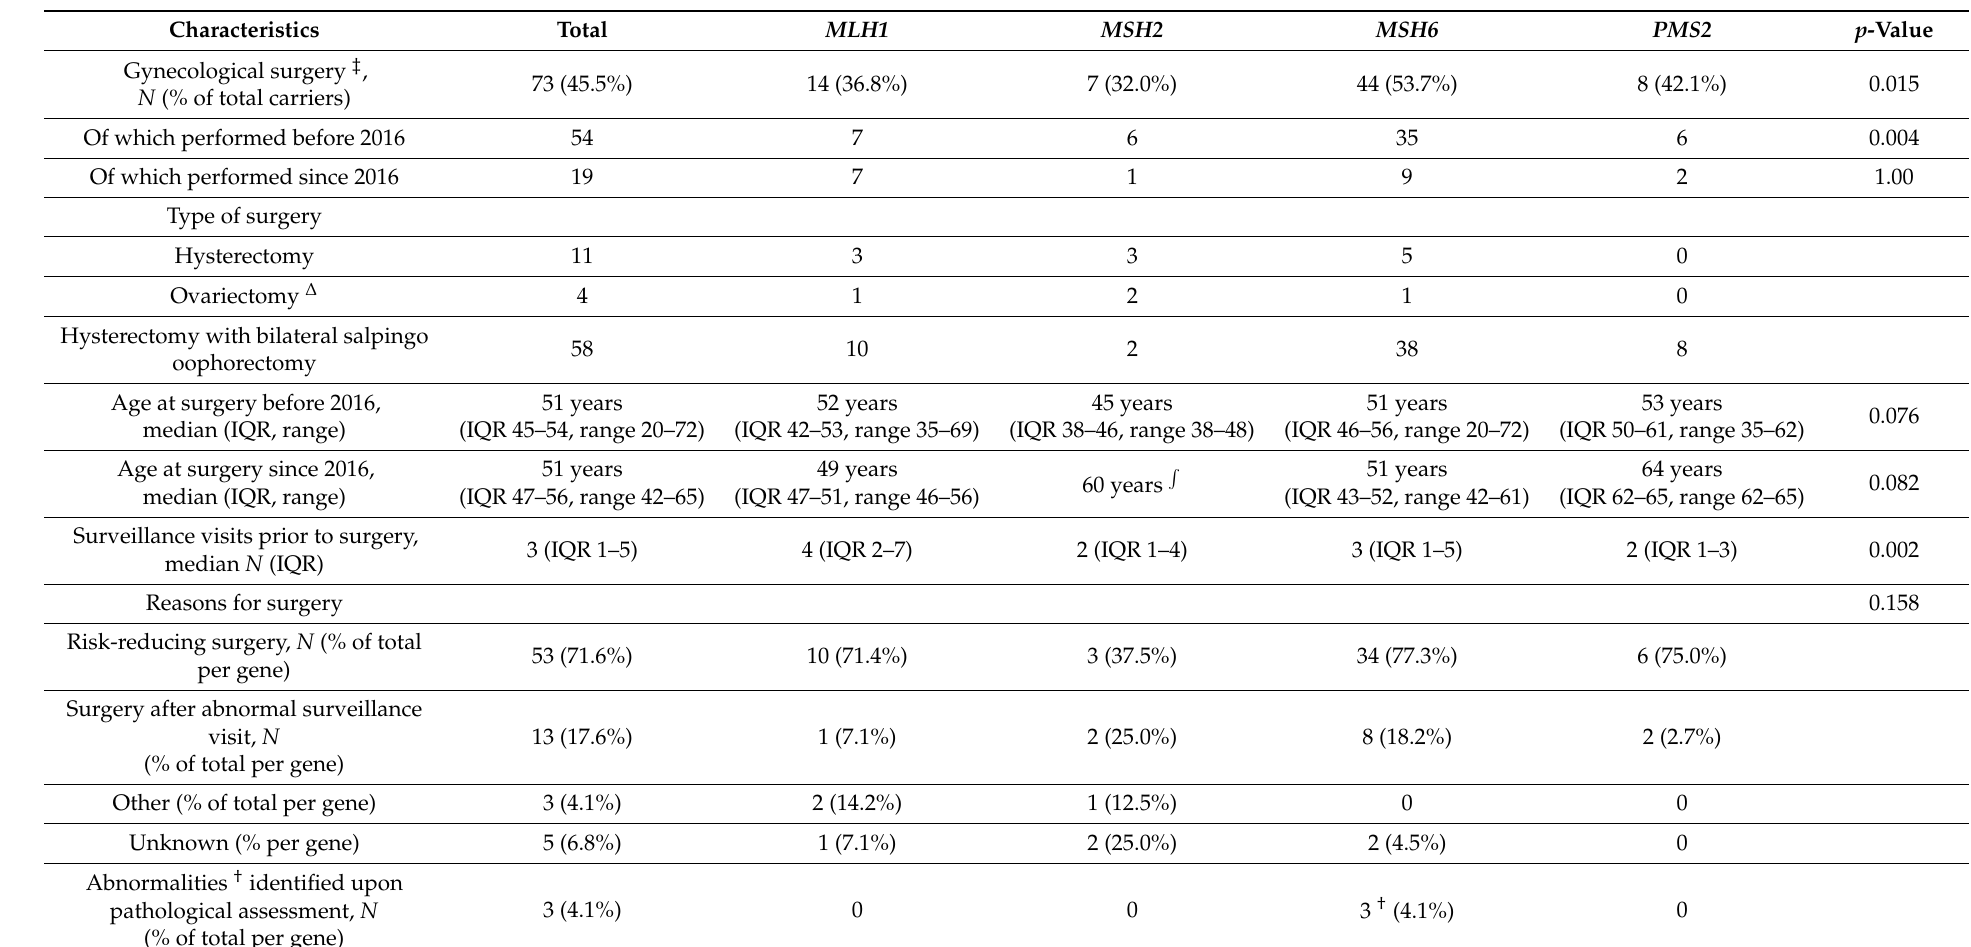
Table 4. Gynecological surgery in patients at gynecological